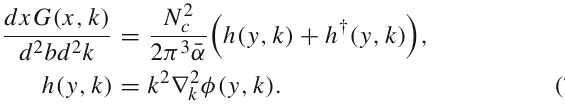
Fig. 7 Gluon density for O–O collisions at Y = 2 and ¯ α = 1 with the total quadruple interaction S 4 (upper left panel), with only S ( 2 ) infrared cut (upper right panel) and without the quadruple pomeron interaction (lower